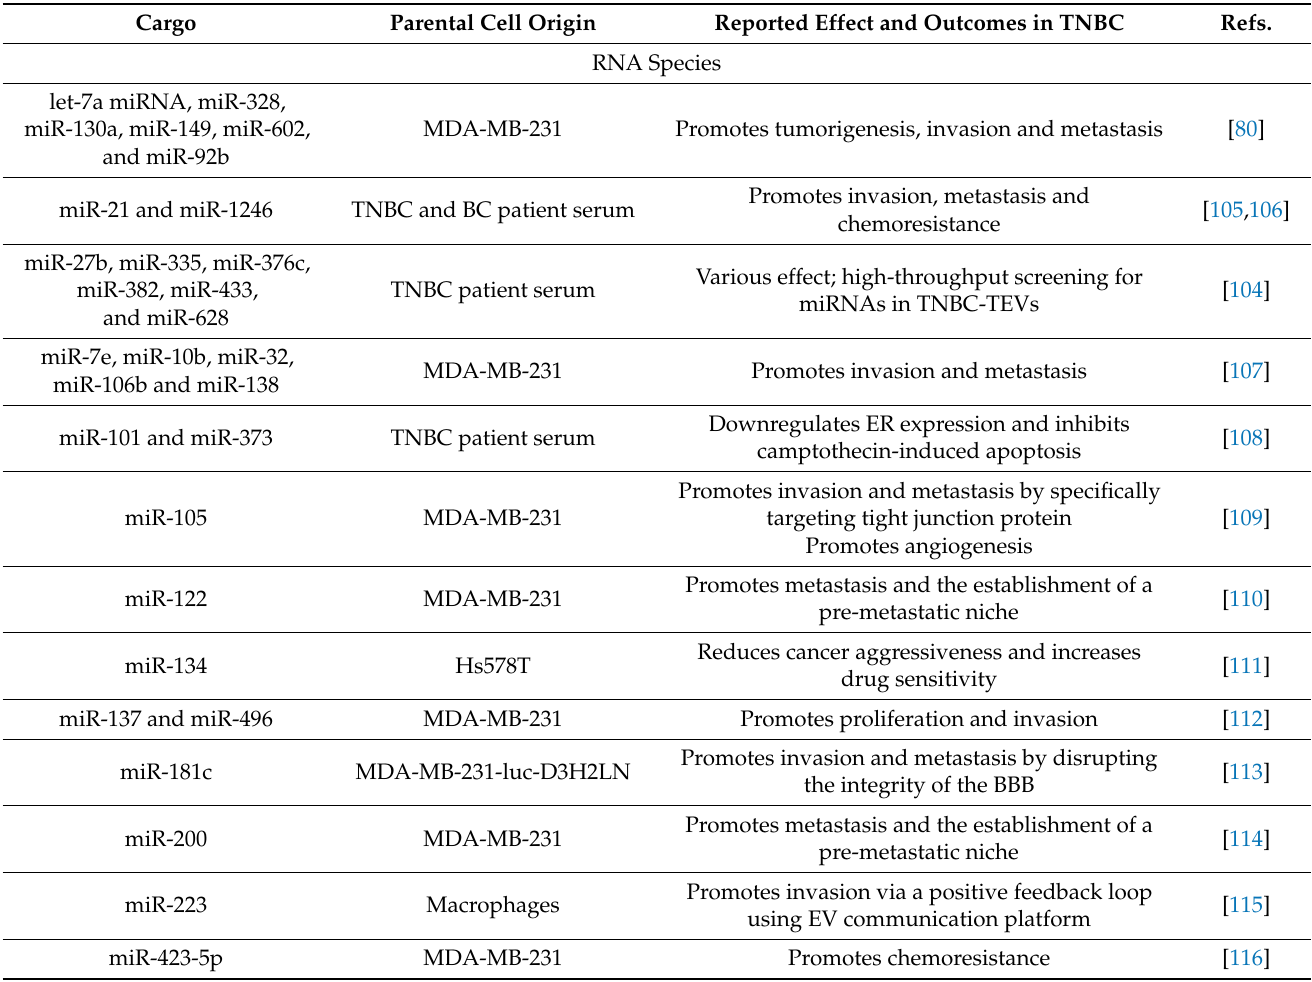
Table 1. TNBC-TEVs encapsulating known RNA species and protein cargo with potential diagno- sis/prognostic value.